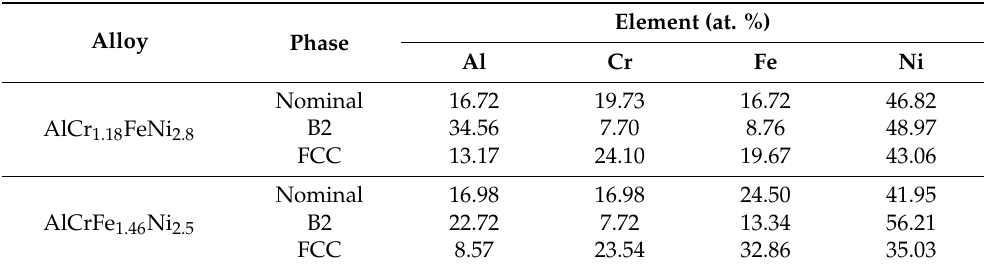
Figure 3. Optical micrographs of as-cast AlCr a Fe b Ni c alloys. ( a ) AlCr 1.18 FeNi 2.8 alloy; ( b ) AlCrFe 1.46 Ni 2.5 alloy. Table 2. Chemical composition of different phases in the AlCr 1.18 FeNi 2.8 and AlCrFe 1.46 Ni 2.5 alloys by EDS (at.